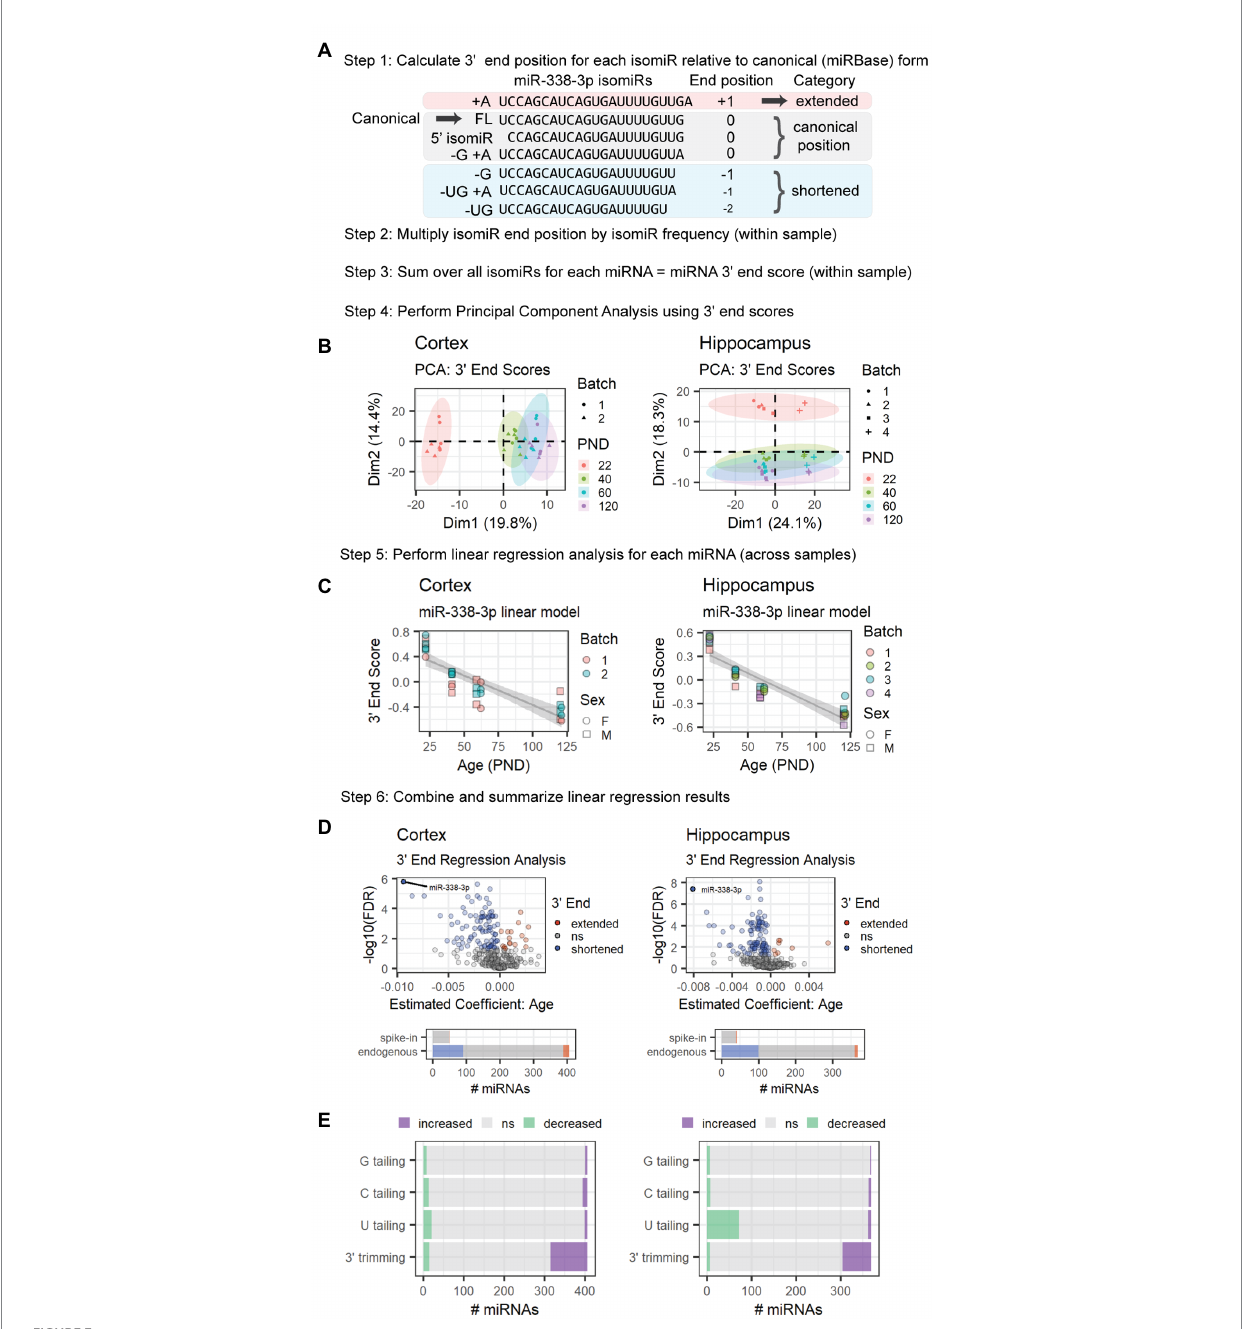
FIGURE 3 MiRNA 3 ′ ends undergo shortening between P22 and P120 in cortex and hippocampus due to increased 3 ′ trimming and decreased 3 ′ U tailing. This schematic provides an overview of the 3 ′ ERA method. MiR-338-3p is used as a representative example, but this method can be applied to any miRNA in a sequencing data set. (A) Alignment of miR-338-3p isomiRs relative to the canonical form, i.e., the sequence listed in miRBase. 5 ′ end variance is ignored in this analysis, as is sequence variance that does not affect miRNA length at the 3 ′ end. Negative 3 ′ end positions correspond with shortened 3 ′ ends; conversely, positive 3 ′ end positions correspond with extended 3 ′ ends. (B) PCA analysis is used to identify outlier samples and to determine whether age or other variables (e.g., batch effects or sex) strongly impact 3 ′ end scores. In the hippocampus data set, Batch 4 consistently differs from the other batches in Dim1, but samples are still clearly separated along Dim2 within each batch. No outliers were identified in either data set. (C) Significance is assessed for each miRNA via linear regression modeling: miRNA 3 ′ end score ~ Age + Batch + Sex. Variables will vary by experiment. Trend lines were fit using the geom_smooth() function in R, with method set to “lm.” A negative Estimate (Age) and negative slope in the trend line for miR-338-3p suggests that miR-338-3p undergoes 3 ′ shortening with age. (D) Volcano plots are used to summarize the linear regression modeling results for endogenous miRNAs. For both our cortical and hippocampal data sets, miR-338-3p undergoes the most 3 ′ shortening between P22 and P120. However, many miRNAs in both data sets undergo 3 ′ shortening (i.e., Estimate <0 and p < 0.05), whereas relatively few undergo 3 ′ extension (i.e., Estimate >0 and p < 0.05). Bar plots indicate the number of miRNAs in each category and include both endogenous and spike-in miRNAs. (E) Regression analysis may be applied to specific 3 ′ end modifications to identify the source of 3 ′ extension or shortening in endogenous miRNAs. In cortex (left), shortening is primarily the result of increased 3 ′ trimming, whereas shortening in hippocampus (right) is due to a combination of increased 3 ′ trimming and reduced U tailing. See Supplementary Figure S4 for sequencing position coverage demonstrating that miRNA 5 ′ end positions are stable with age whereas position coverage at the 3 ′ end is consistent with 3 ′ shortening in -3p and -5p miRNAs in both